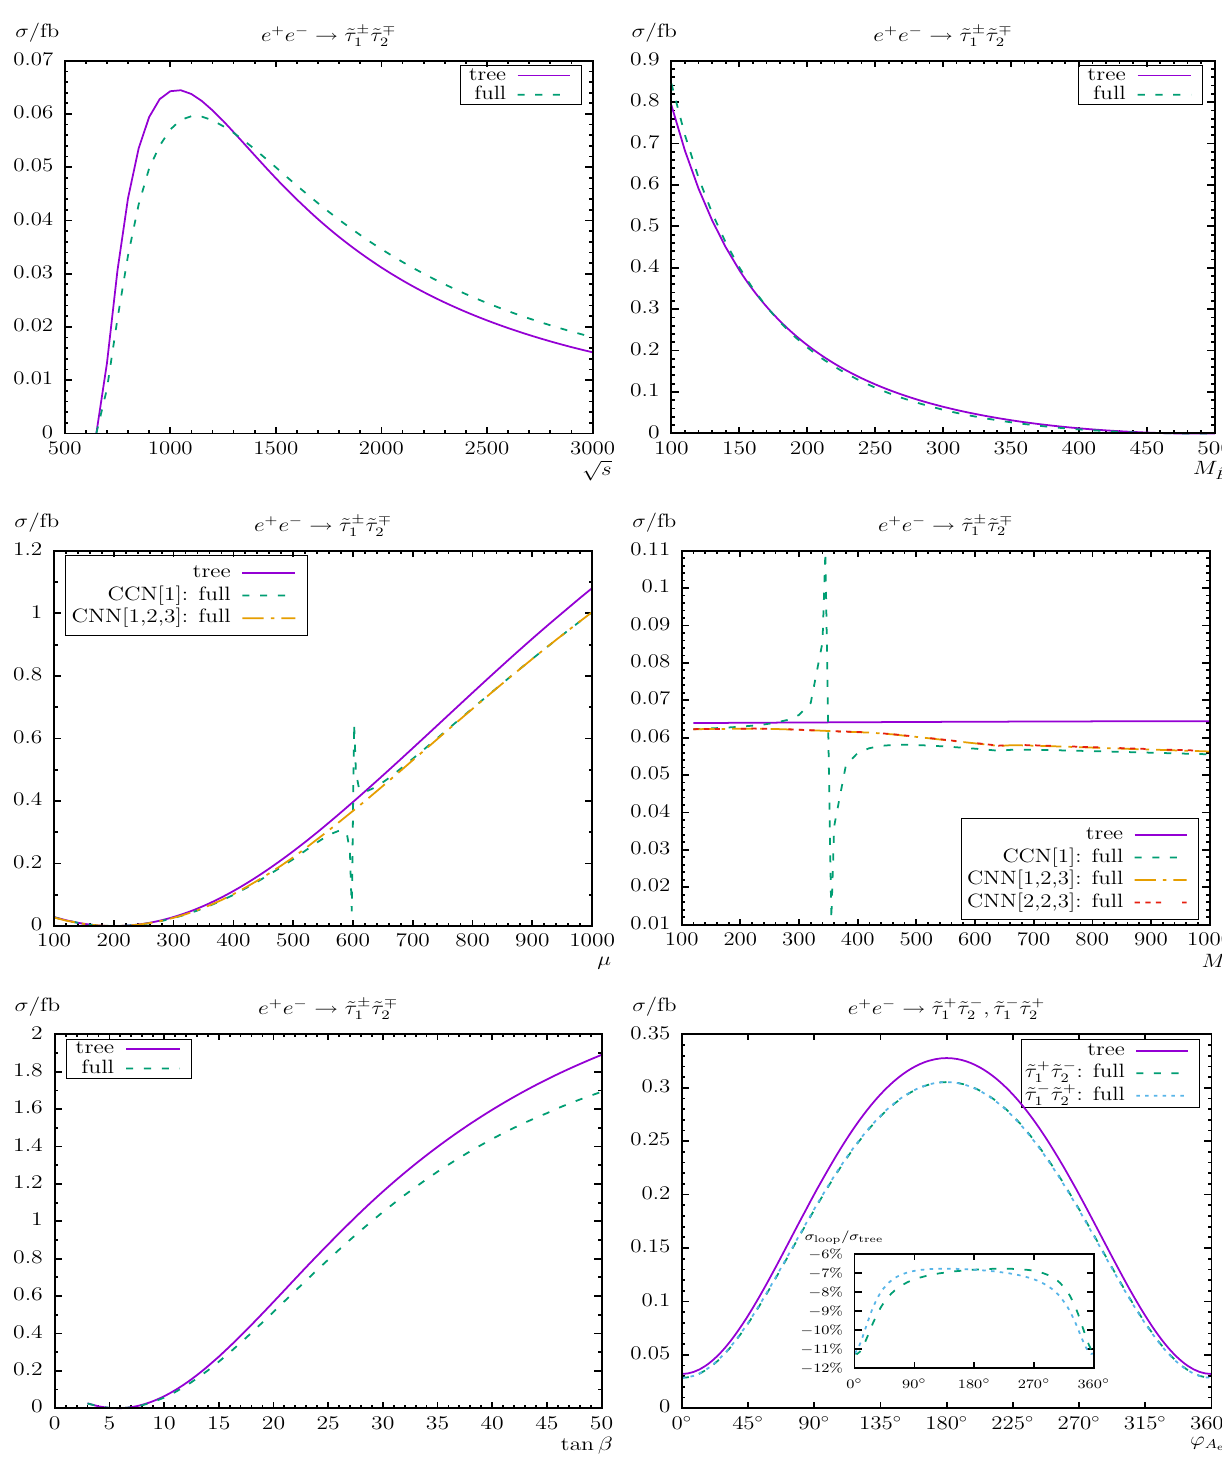
˜ τ ∓ ) . Tree-level and full one-loop corrected 1 2